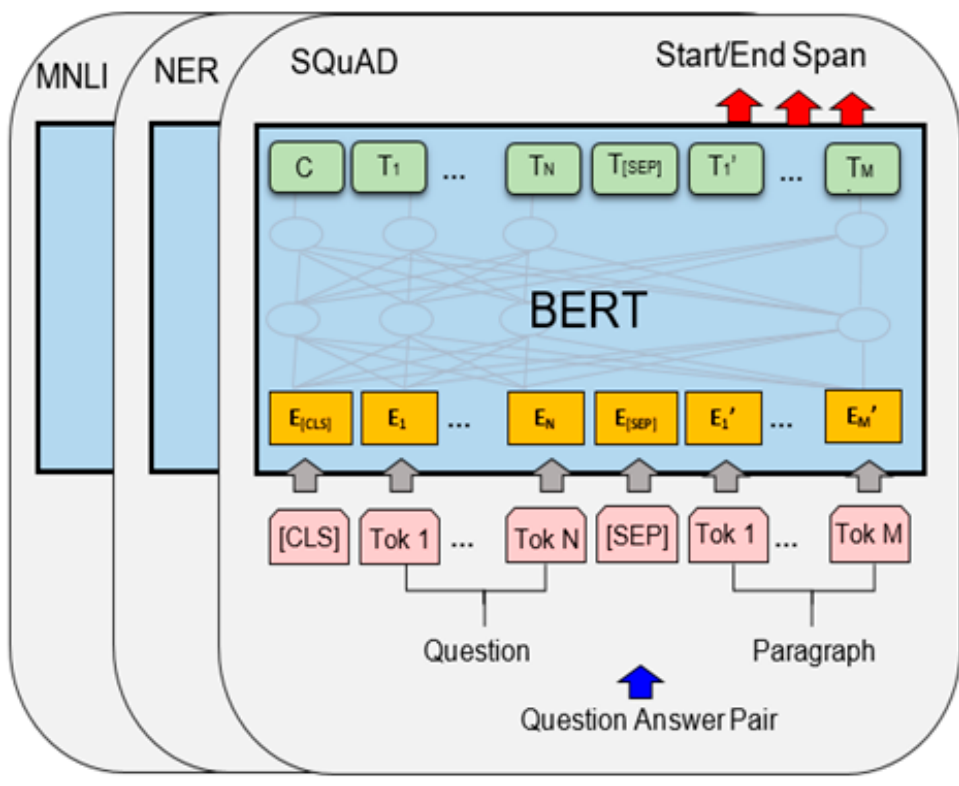
Figure 27. BERT-Fine Tuning [69].